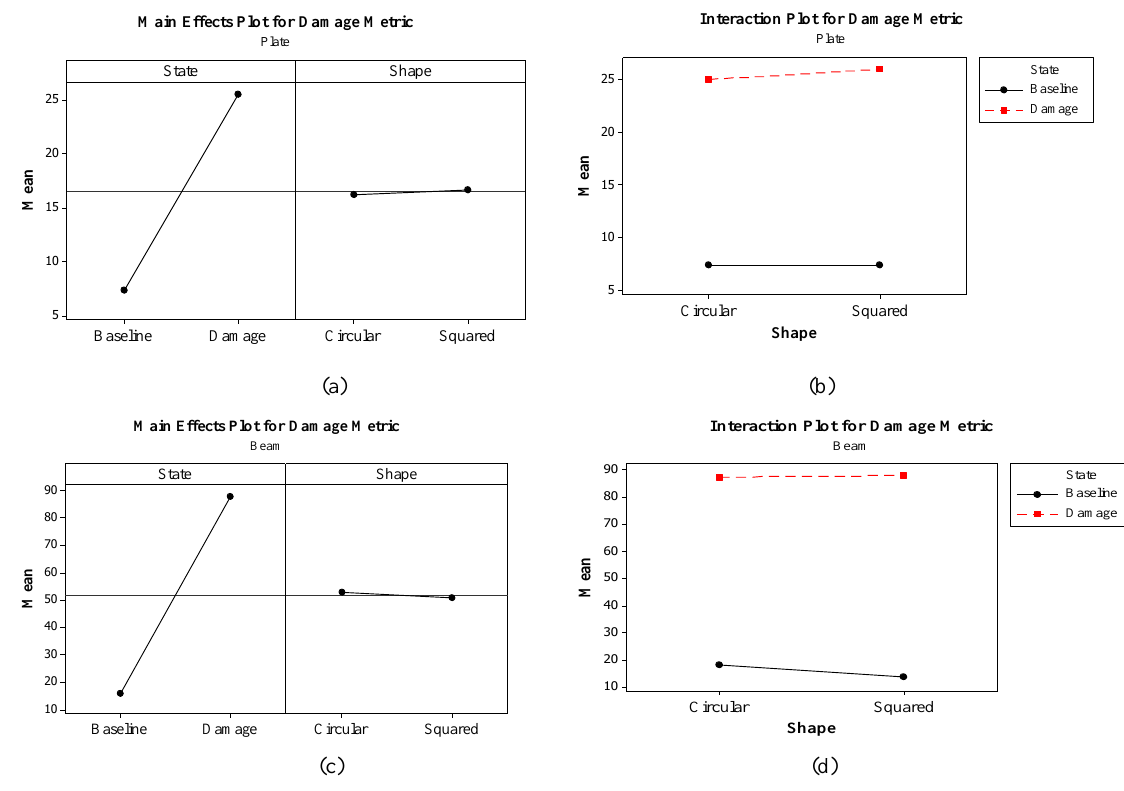
Fig. 4. Main effects of the sensor shape (a) Isolated effects for the plate; (b) Cross effects for the plate; (c) Isolated effects for the beam; (d) Cross effects for the beam.